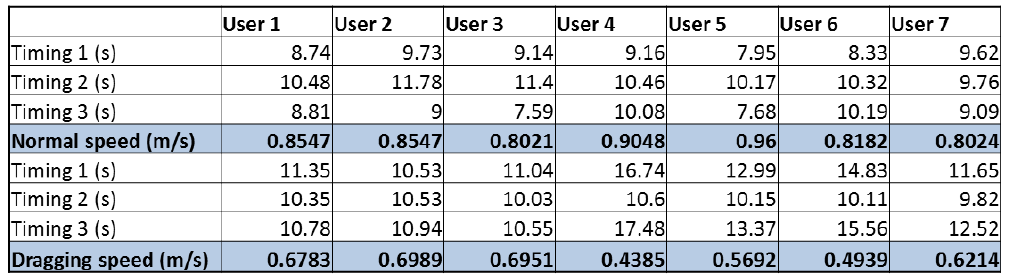
Table 1. Speed table for the different